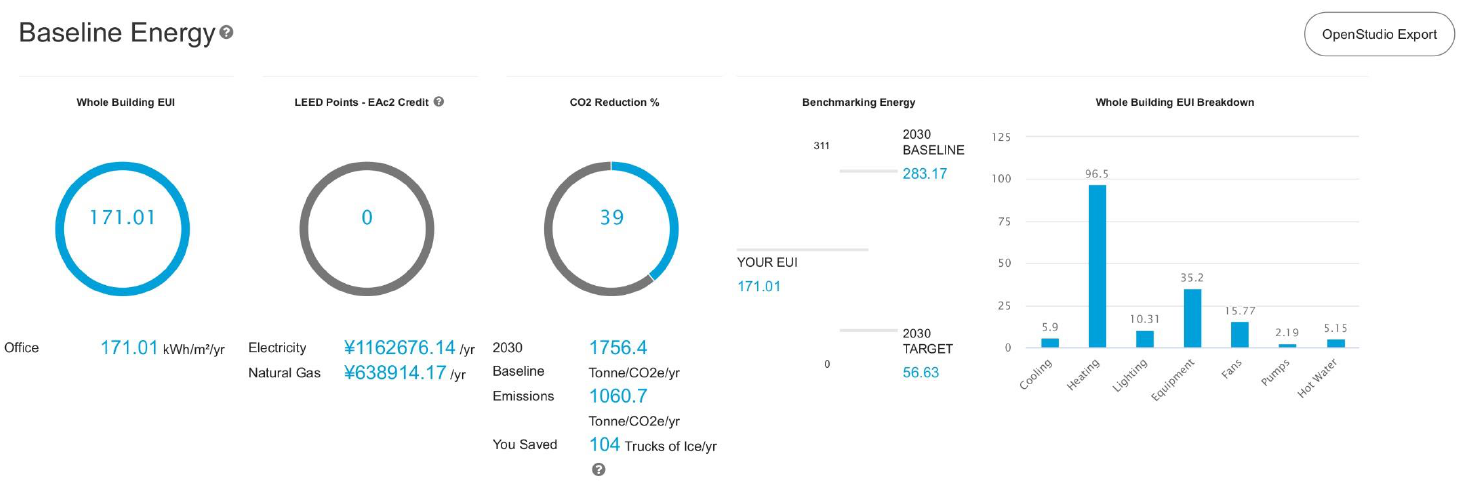
Figure A8. Zone 3-A Shanghai, Shanghai (post-COVID-19 78% scenario).